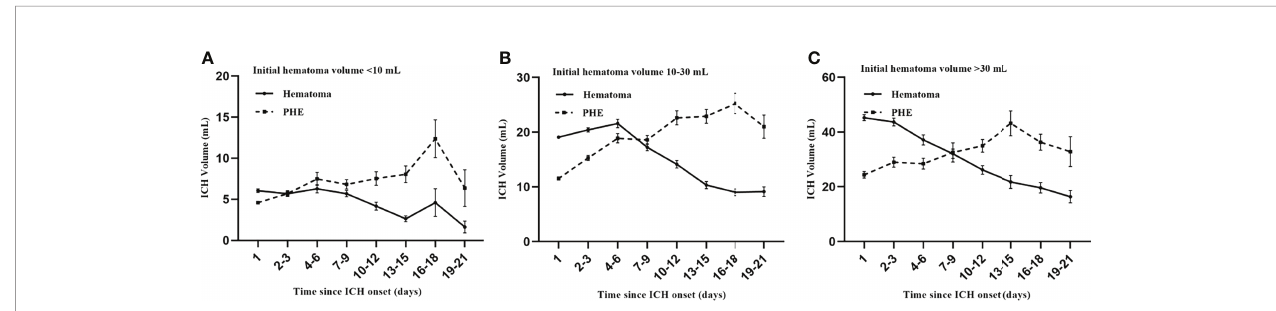
FIGURE 4 | Time course of ICH evolution. The growth pattern for PHE (A – C) is more variable compared to the hematoma (A – C) . Patients have a signi fi cant fi nal peak PHE formed after approximately two weeks (A – C) . The PHE grows slowly after the fi rst week in patients with an initial hematoma volume of less than 30 mL (A, B) . Similarly, the PHE maintains a stable growth rate after the fi rst week in patients with initial hematoma larger than 30 mL (C) .